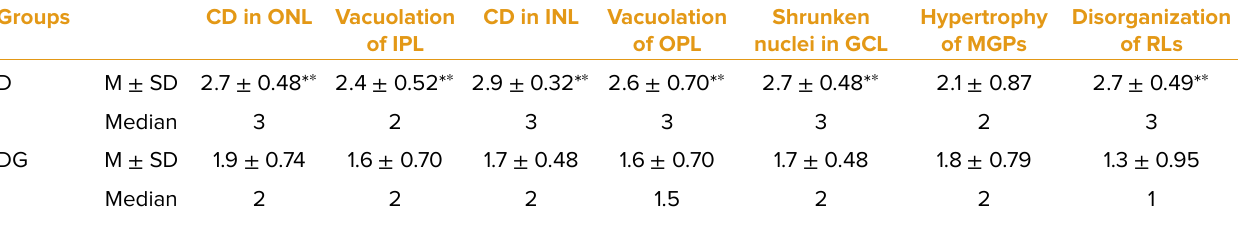
CD, cellular degeneration; ONL, outer nuclear layer; IPL, inner plexiform layer; INL, inner nuclear layer; OPL, outer plexiform layer; GCL, ganglion cell layer; MGPs, Müller glia processes; RLs, retinal layers; M ± SD, mean ± standard deviation Asterisk (*) at each column represents a significant difference ( P < 0.05);